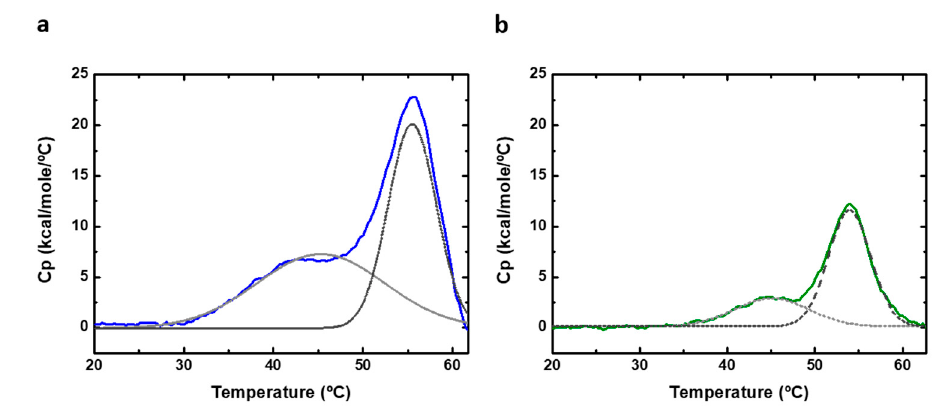
Figure 7. Differential scanning calorimetry (DSC) of human PAH. DSC thermograms of ( a ) 5 µM of full-length PAHt construction and ( b ) 5 µM of double truncated PAHd construction. Original profiles are normalized to protein concentration and the baseline subtracted. The excess heat capacity is shown. Dashed gray lanes correspond to deconvoluted peaks of DSC thermograms.